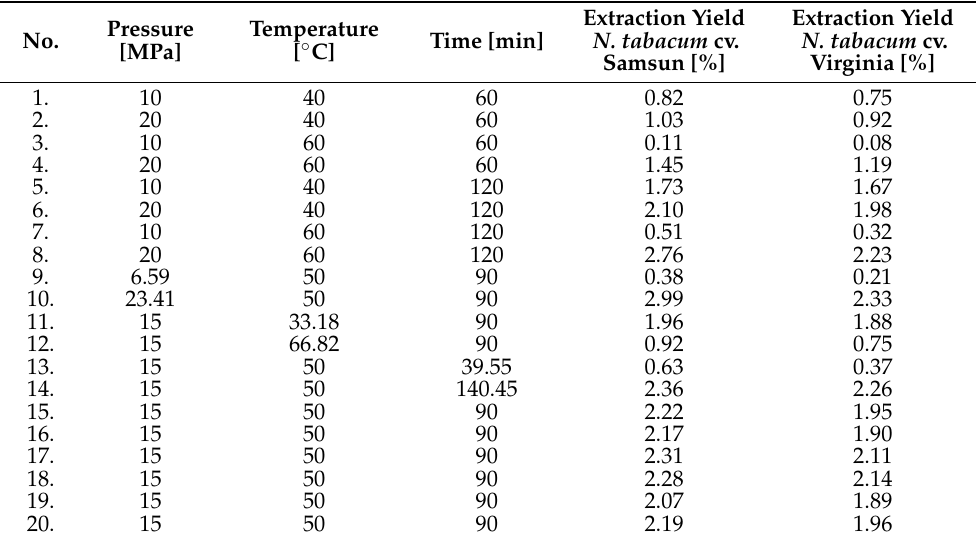
Table 3. The response surface regression coefficients of the polynomial function for the N. tabacum cv. Samsun and N. tabacum cv. Virginia leaves total extraction yield [%]. Term Coefficient Extraction yield N. tabacum cv.